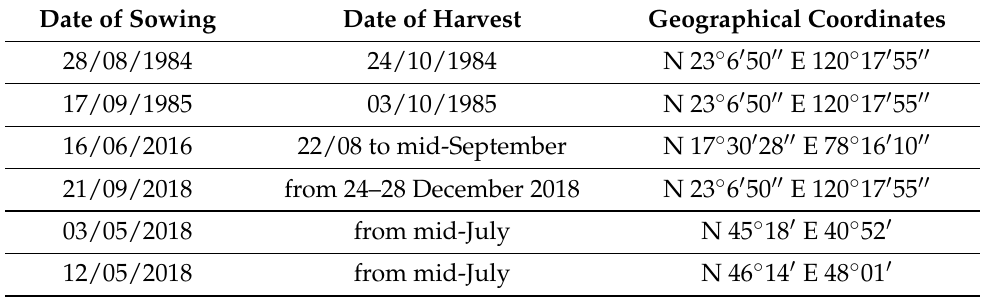
Table 1. Information on field experiments.